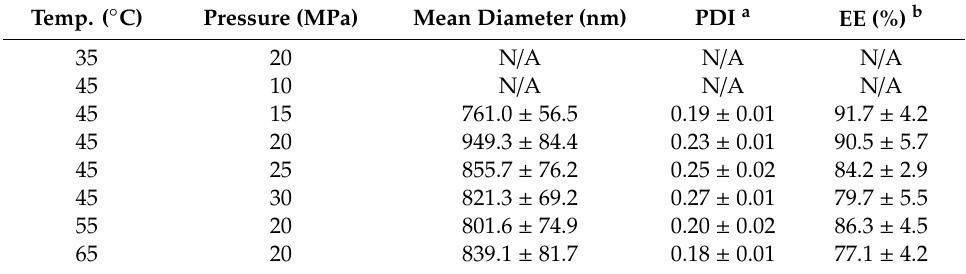
Table 3. E ff ects of pressure and temperature on the SCF-CO 2 process of liposomal AmB. Temp. ( ◦